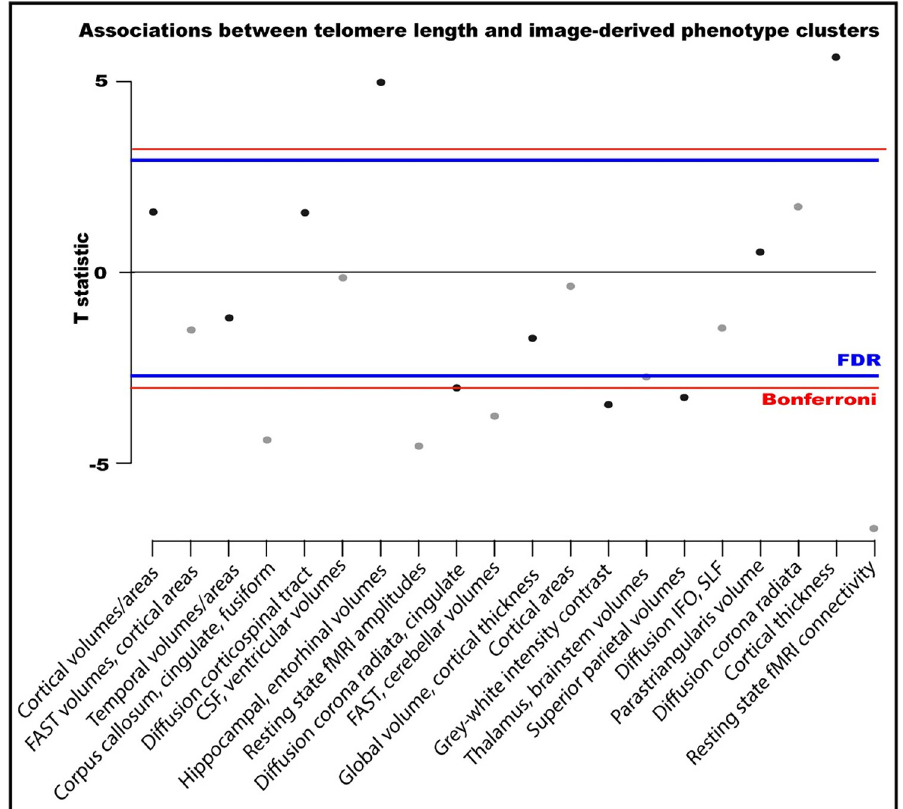
Fig 3. Associations between leucocyte telomere length and imaging clusters from an independent components analysis-based dimensionality reduction on 3921 image-derived phenotypes. Associations were adjusted for all imaging-related confounders, age, age 2 , age 3 , sex, age � sex, smoking, alcohol intake, body mass index, leucocyte count, genetic ancestry. Constituents of clusters are in S5 Table. Multiple testing T statistic thresholds were calculated on the basis of 20 tests: False Discovery Rate (FDR) = 2.50, Bonferroni = 3.02.